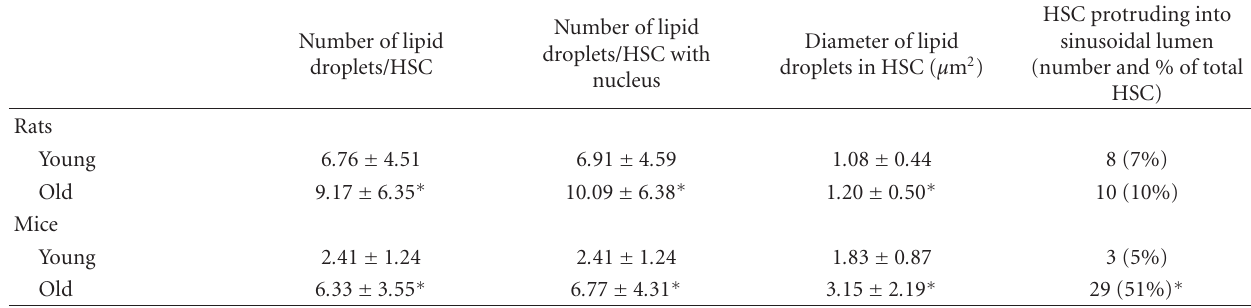
Table 1: Transmission electron microscopic analyses of the e ff ects of old age on